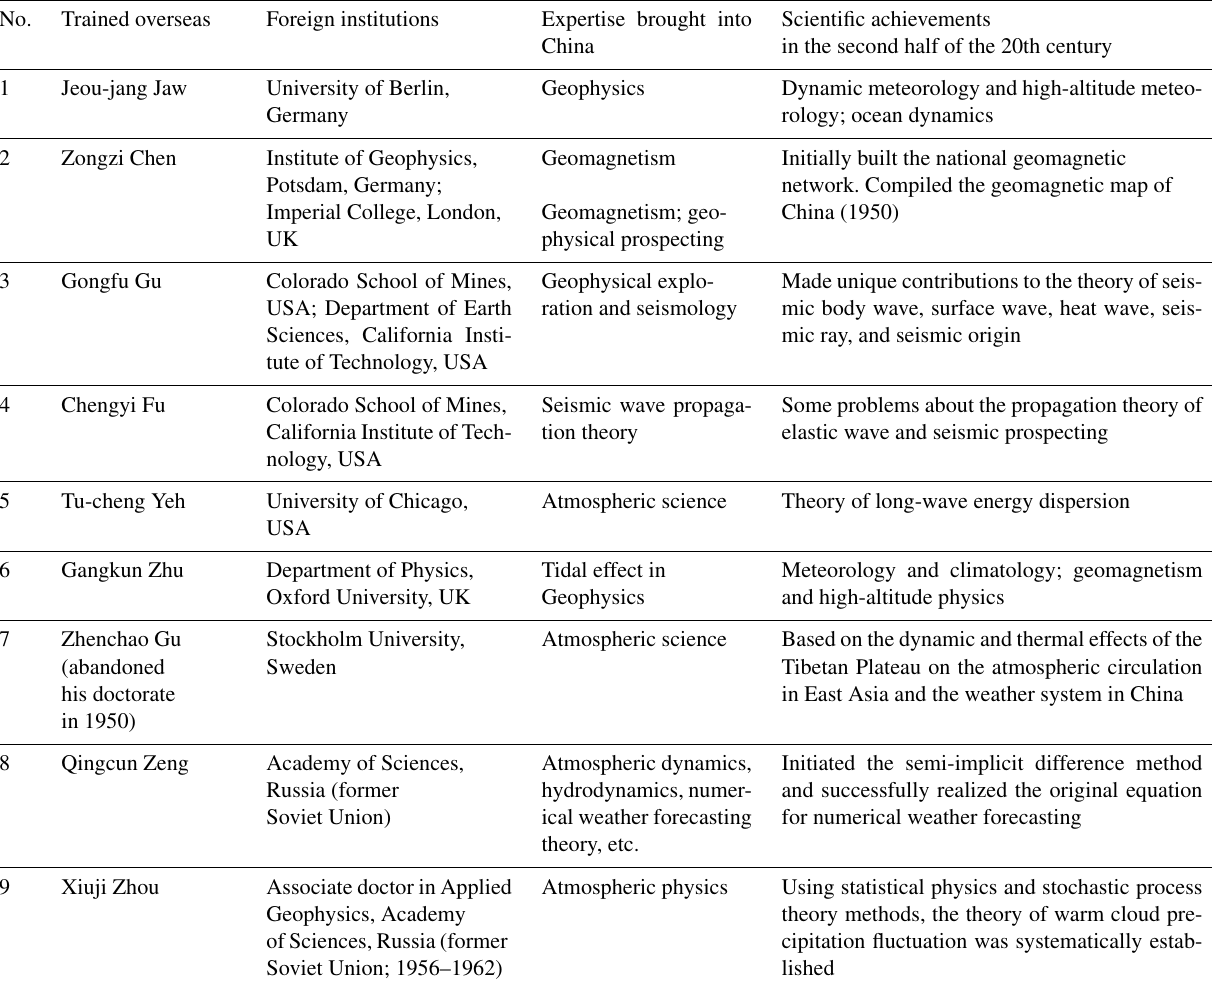
Table 1. Scientists who were educated abroad and who worked at the IGCAS in the early years. No. Trained